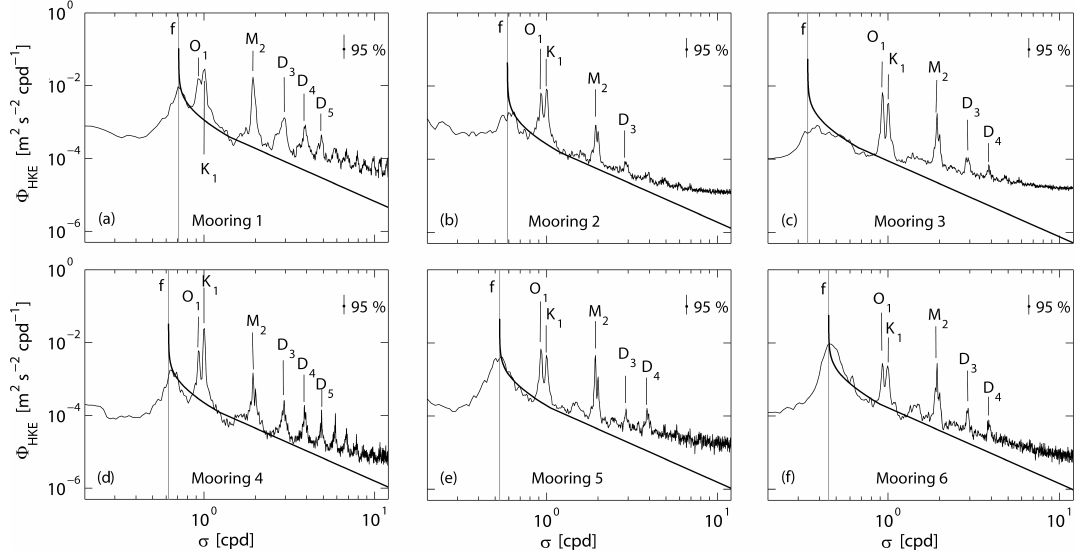
Figure 11. (a–f) Rotary spectra (clockwise plus counterclockwise) of horizontal kinetic energy for the six moorings deployed in the SCS (1cpd = 1day − 1 ) . Spectra are averaged over z ∈ [60:270]m. The canonical Garrett and Munk spectrum is shown for reference (smooth curve). The vertical lines represent various frequencies ( f , O 1 , K 1 ... ). The 95% statistical significance level is indicated by the vertical bar in the upper-right